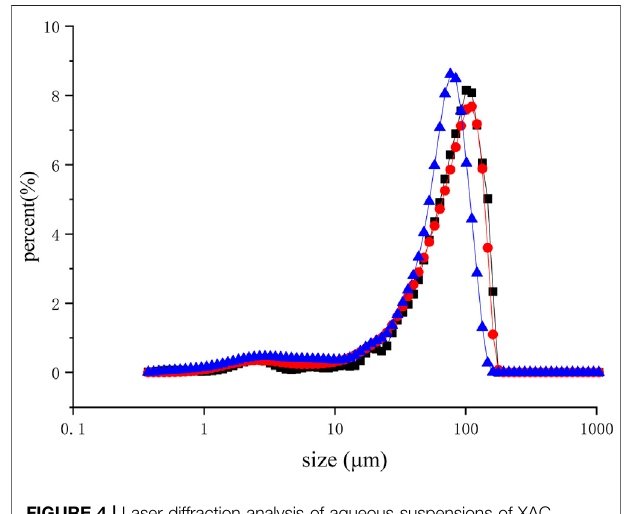
FIGURE 4 | Laser diffraction analysis of aqueous suspensions of XAC using ultrasound (40 kHz, 0.40 W/cm 2 ) for different durations. ( ■ , Control; C , 10 min; ▲ , 40 min)